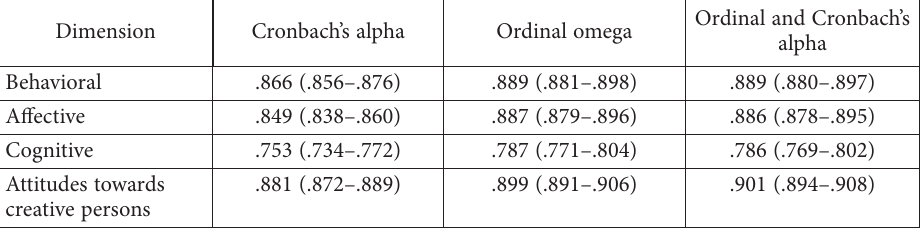
Table 4. Reliability coefficients according to dimension and total test (source: created by authors) Dimension Cronbach’s alpha Ordinal omega